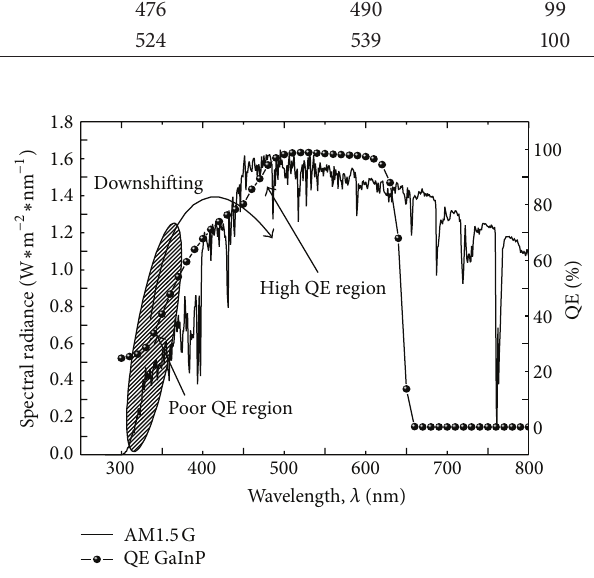
Figure1:SolarspectrumAM1.5G,quantumefficiencyofGaInPcell, and principle of downshifting.